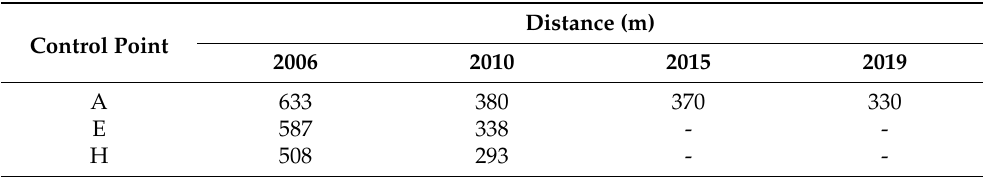
Table 7. Distance evolution to control points over